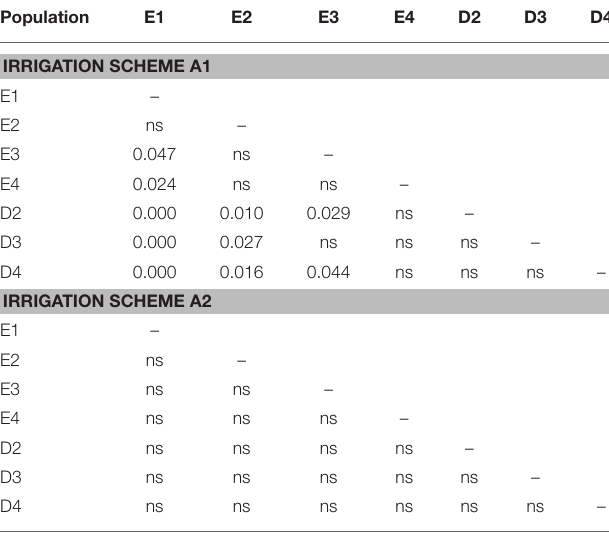
TABLE 1 | Significance of differences ( p -values) in final seedling survival among populations under irrigation